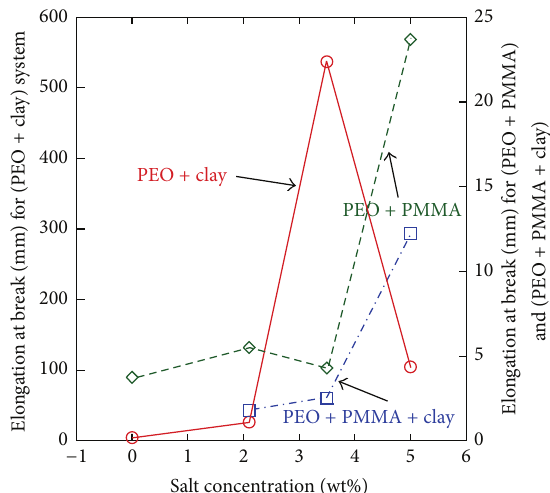
Figure 11: Variation of elongation at break for PEO/Clay (PC), PEO/PMMA, and PEO/PMMA/Clay (PPC) composite and blend composite system with varying content of salt.